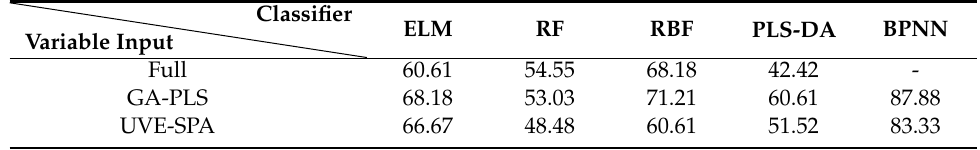
Table 3. Modeling performances to classify all 10 varieties on a test set built from the full spectral range and subsets of the selected variable using di ff erent